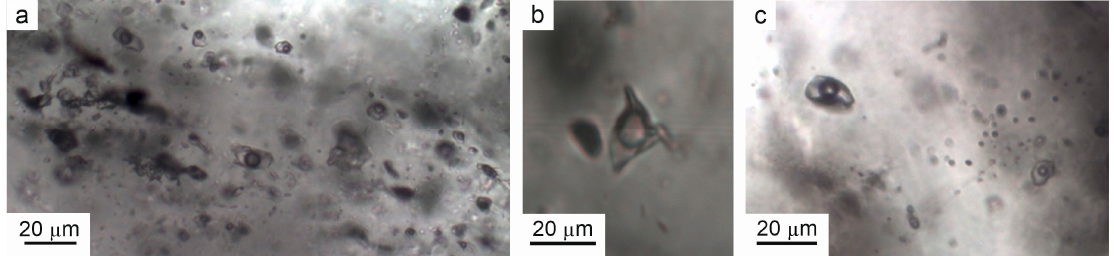
Figure 5. Photomicrographs showing different types of fluid inclusions in the ore-bearing quartz: ( a )—fluid inclusions in quartz (sample 053); ( b )—fluid inclusion (16 С _2fi, see Figure 6), with the gas phase represented by the СО 2 mixture not exceeding 0.05 g/cm 3 in density, N 2 , and CH 4 in ratio 0.92/0.07/0.01; ( c )—coexistence of two-phase fluid inclusions with different fill factors (sample 016 C).